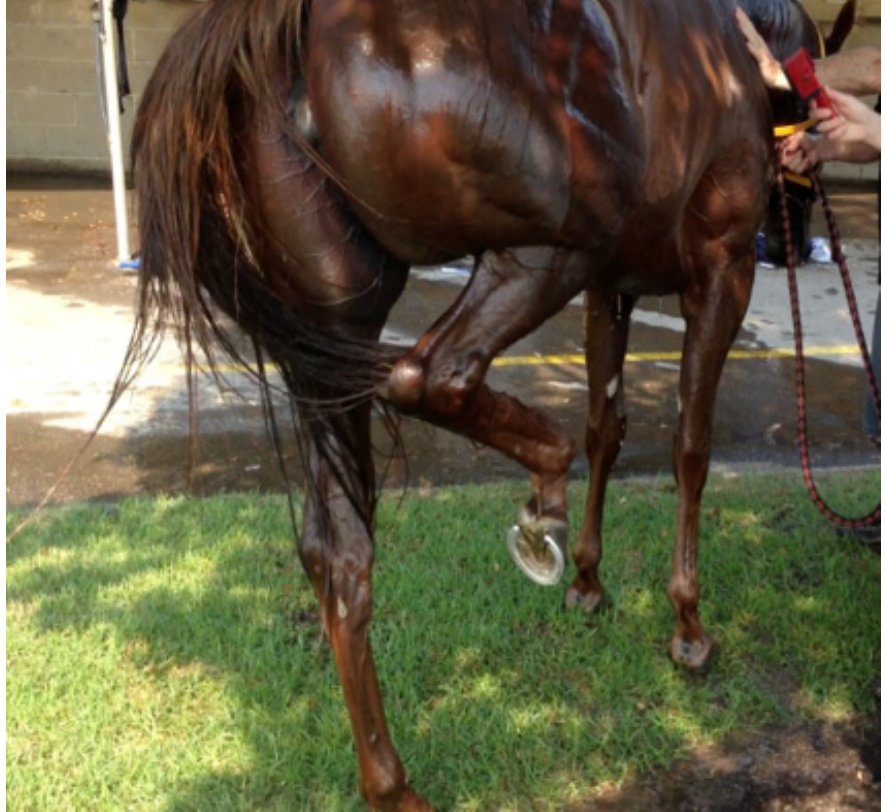
Figure 10. Level 2 EHI: This horse is displaying kicking-out behaviour. It may be random and only spasmodic, or continuous and quite violent, and can easily be misdiagnosed as a colic episode. Source—J Equine Vet Ed, 2021.